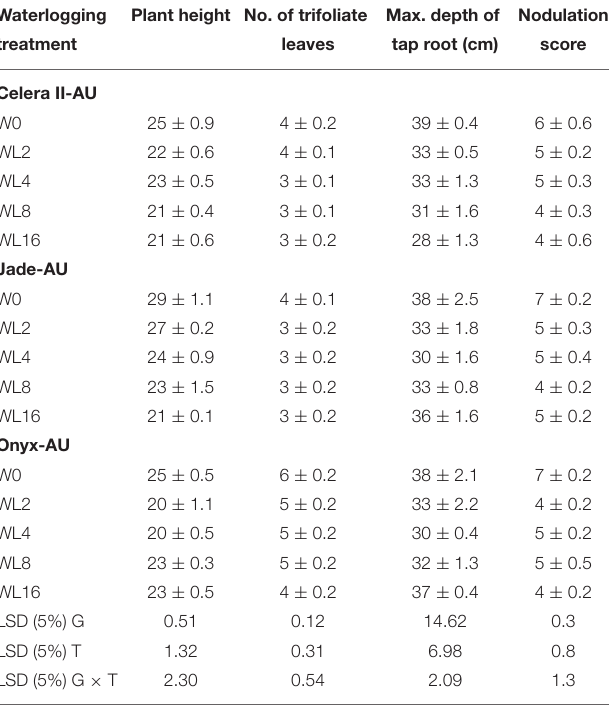
TABLE 5 | Plant height, number of trifoliate leaves, maximum depth taproot depth, and nodulation score at the end of the recovery, as affected by the duration of transient waterlogging.